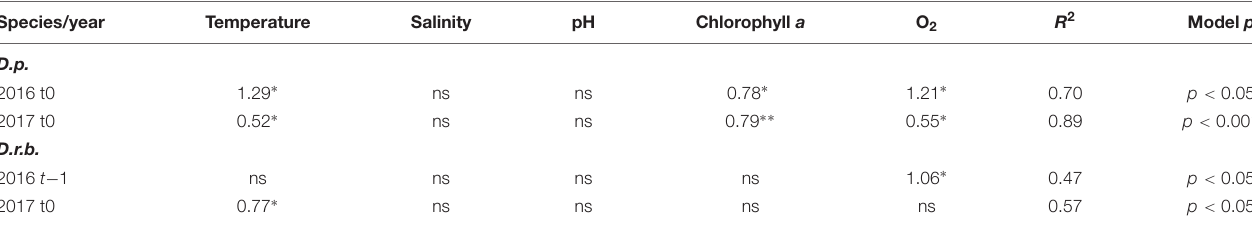
TABLE 5 | Multiple regression analysis for relationships between dreissenid biomasses ( D.p ., D. polymorpha ; D.r.b ., D. rostriformis bugensis ) and environmental variables (at t0 and t − 1) in the near-bottom water layer; significant regression coefficients shown